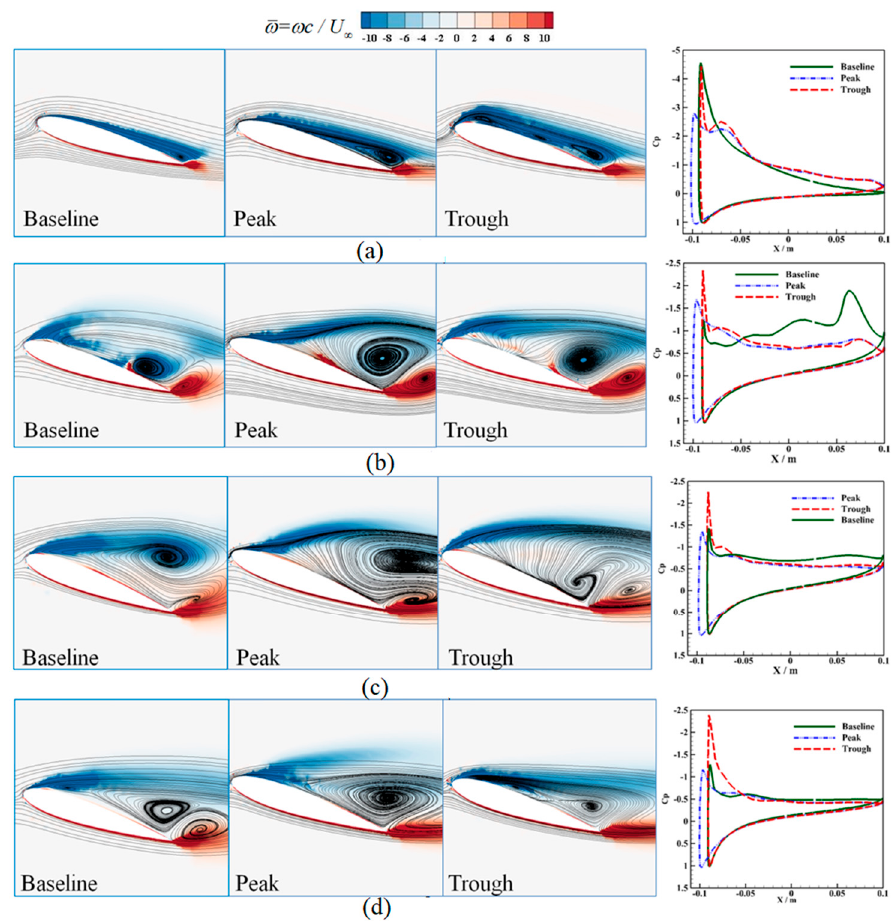
Figure 15. Flow fields and pressure coefficients of different sections at different angles of attack. ( b ) 18° ↑ ( c ) 20° ↑ ( d ) 17° ↓ .